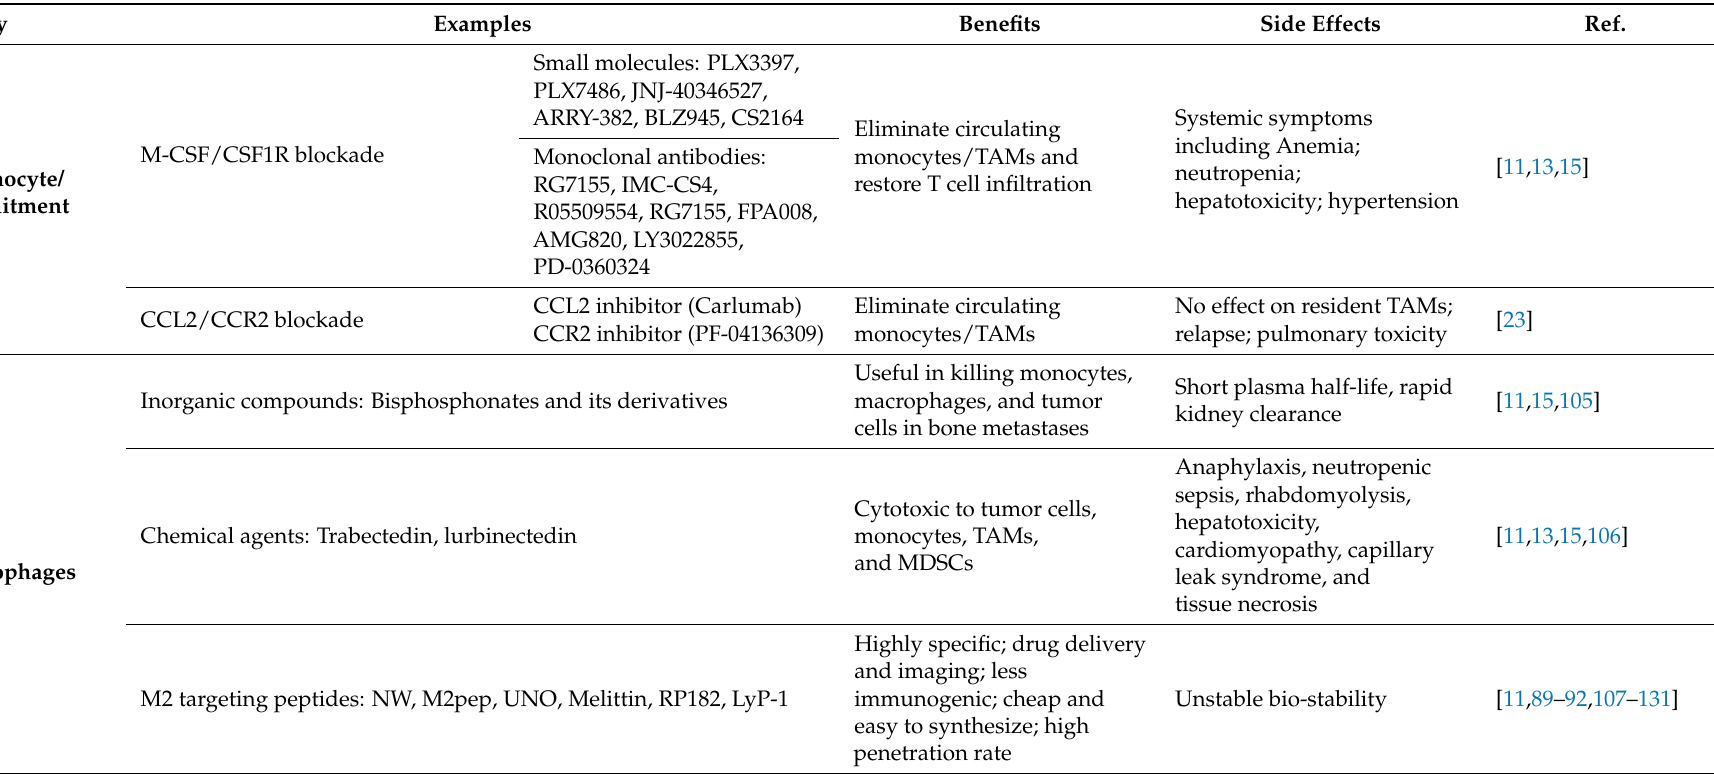
Table 2. Therapeutic strategies targeting